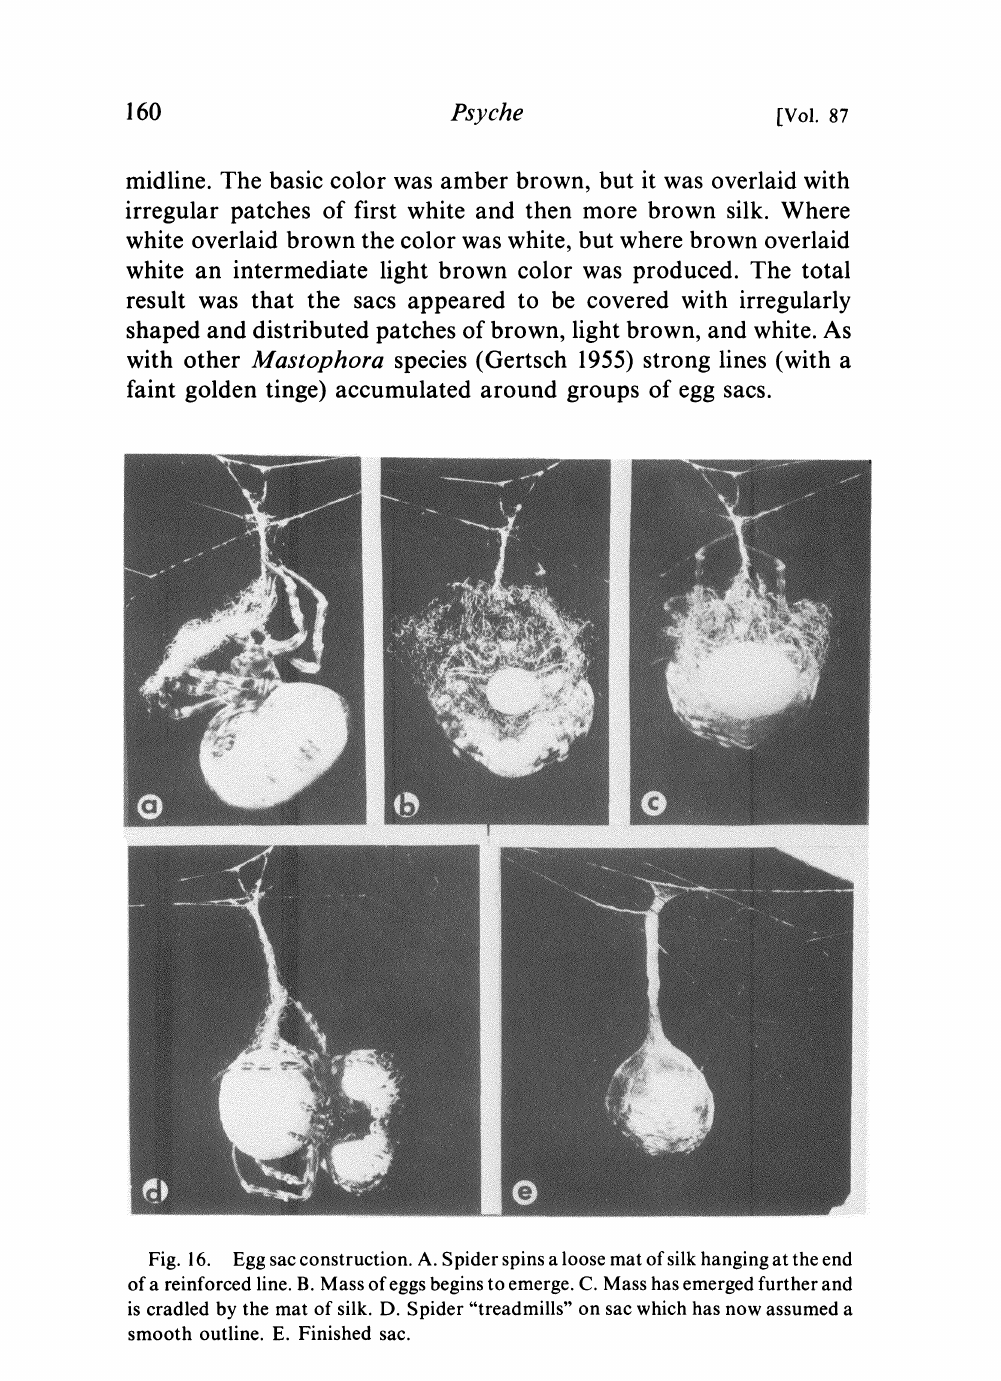
midline. The basic color was amber brown, but it was overlaid with irregular patches of first white and then more brown silk. Where white overlaid brown the color was white, but where brown overlaid white an intermediate light brown color was produced. The total result was that the sacs appeared to be covered with irregularly shaped and distributed patches of brown, light brown, and white. As with other Mastophora species (Gertsch 1955) strong lines (with a faint golden tinge) accumulated around groups of egg sacs.